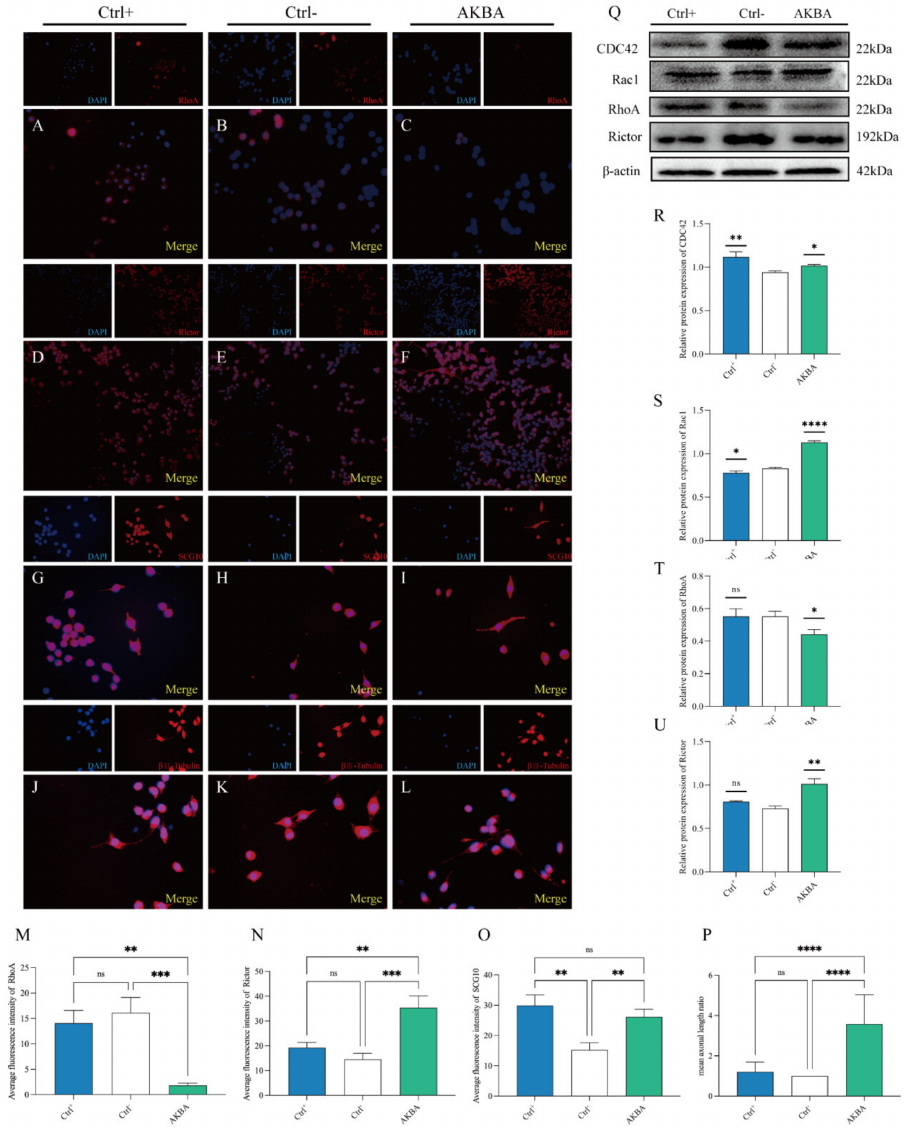
Figure 7. Improved growth of neuronal synapses in PC12 cells after AKBA treatment. ( A – C ) RhoA immunofluorescence staining of different groups of PC12 cells. ( D – F ) Rictor